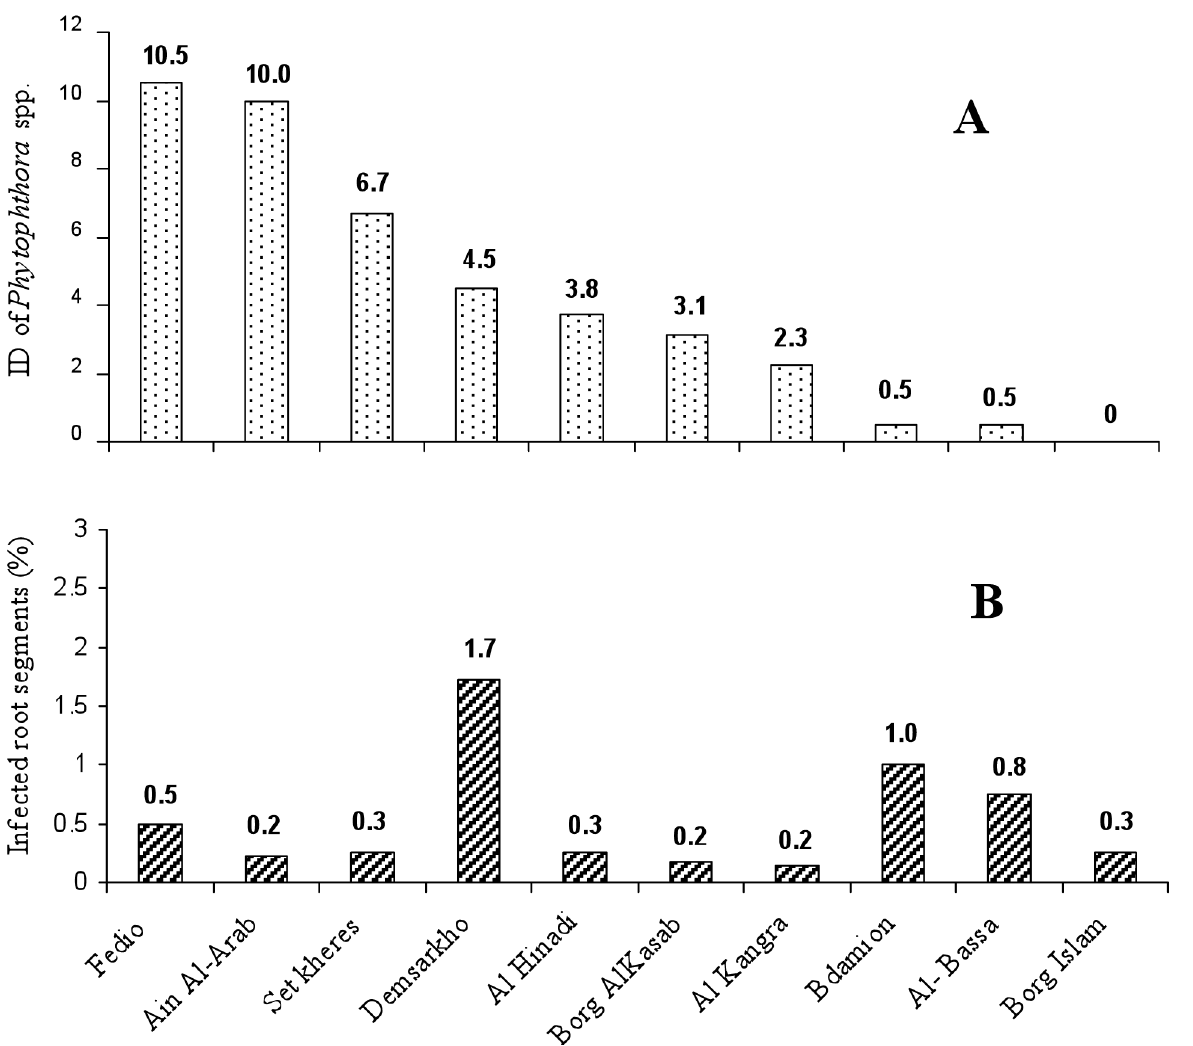
Figure 3. Inoculum density (ID) of Phytophthora spp. (propagules gram -1 of dry soil) (A), and percentage of infected roots (B) in monitored locations in Latakia